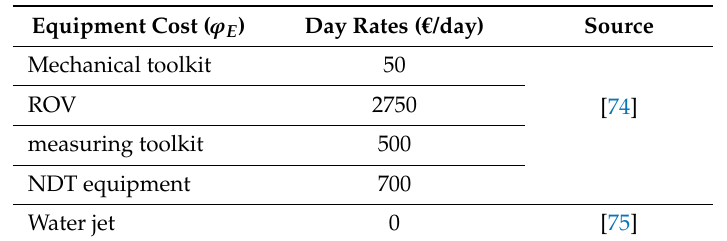
Table 12. Equipment costs.